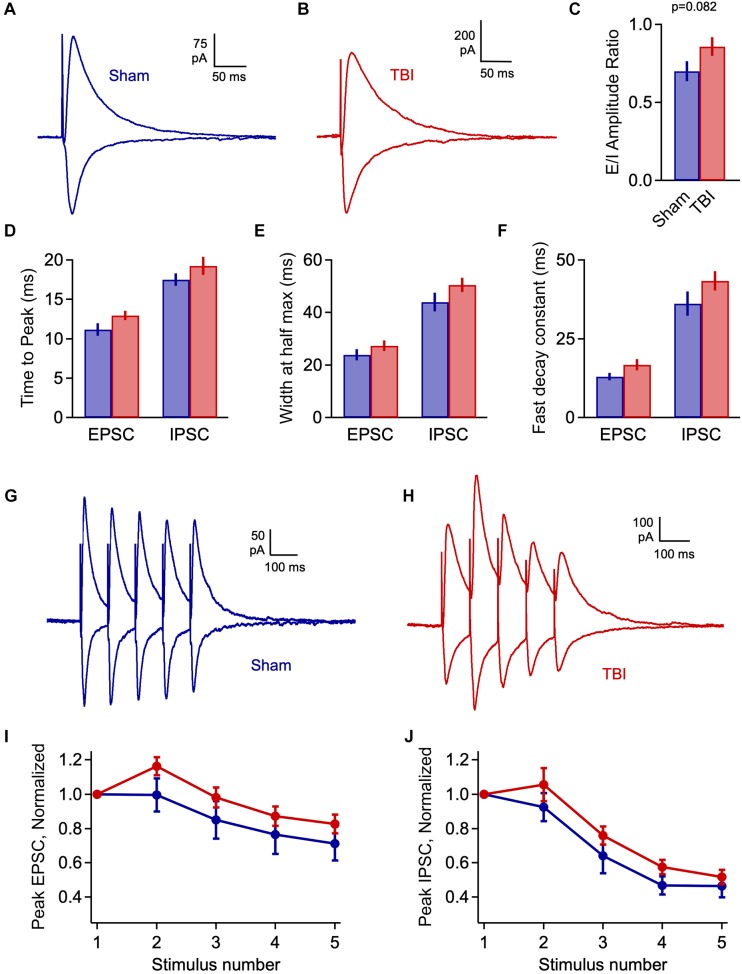
Injury has limited effects on evoked E-I balance 1 h post-injury. (A,B) Excitatory and inhibitory inputs in piriform pyramidal cells elicited by LOT stimulation. (C) Excitatory-inhibitory ratio was slightly but non-significantly increased after TBI [0.700 ± 0.065 vs. 0.858 ± 0.060 for sham and TBI; p = 0.082; t(66) = 1.76; 2 sample t-test; n = 9 mice, 28 cells for sham; 12 mice, 40 cells for TBI]. (D) Time to peak is not significantly changed by injury [EPSCs: 11.2 ± 0.8 vs. 12.9 ± 0.6 ms for sham and TBI; p = 0.074; t(59) = –1822; 2 sample t-test; IPSCs: 17.5 ± 0.8 vs. 19.3 ± 1.1 ms; p = 0.280; t(61) = –1.090; t-test]. (E,F) Width at half-maximum and decay time constant were not significantly affected [half width – EPSCs: 23.8 ± 2.1 vs. 27.3 ± 2.0 ms; p = 0.266; t(59) = –1.122; IPSCs: 43.9 ± 3.5 vs. 50.5 ± 2.8 ms; p = 0.151; t(61) = –1.454; decay time constant: EPSCs: 12.9 ± 1.2 vs. 16.7 ± 1.7 ms; p = 0.148; t(59) = –1.466; IPSCs: 36.2 ± 3.8 vs. 43.4 ± 3.1 ms; p = 0.152; t(61) = –1.450]. 2-sample t-test used for all kinetics comparisons: EPSCs, n = 9 mice, 22 cells and 12 mice, 39 cells for sham and TBI; IPSCs, n = 9 mice, 23 cells and 9 mice, 40 cells for sham and TBI. (G,H) Example responses to 10-Hz trains of LOT stimulation. (I,J) Short-term synaptic plasticity for excitatory (left) and inhibitory (right) responses, which was slightly but not significantly enhanced (EPSCs: p > 0.14 for all pulses; IPSCs: p = >0.19 for all pulses).